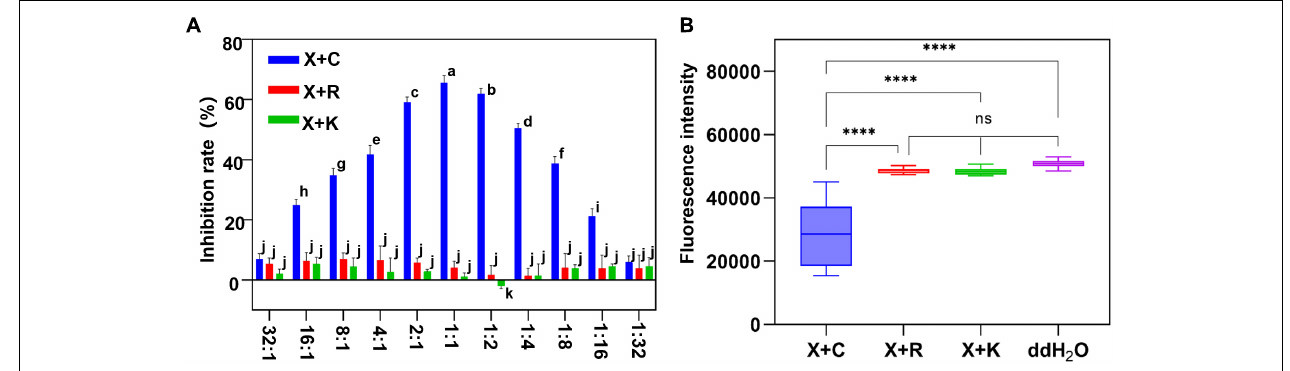
FIGURE 4 | The inhibition evaluation and screening of mixture formulation bactericides. (A) The inhibition rate of three different mixture formulations of bactericides was evaluated. The y -axis represents the inhibition rate, and the x -axis represents the synergistic ratio of bactericides. Statistical analysis was studied by two-way ANOVA following multiple comparisons with the Tukey’s test (95% CI) using GraphPad Prism 9. Different letters in the bars indicate significant differences among the treatments. (B) Xcc-eYFP expressing fluorescence intensity in three mixture formulations of bactericides was captured under the SparkTM Multimode Microplate reader at 6 h postincubation. The x -axis represents three synergetic bactericides, ddH 2 O: double-distilled water, the y -axis represents the fluorescence intensity. Statistical analysis was studied by one-way ANOVA following multiple comparisons with the Tukey’s test (95% CI) using GraphPad Prism 9. ( ∗∗∗∗ p < 0.0001,